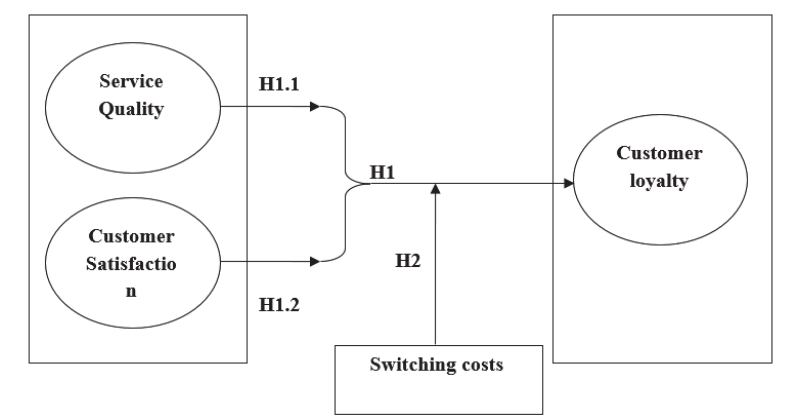
Fig. 1. Proposed research